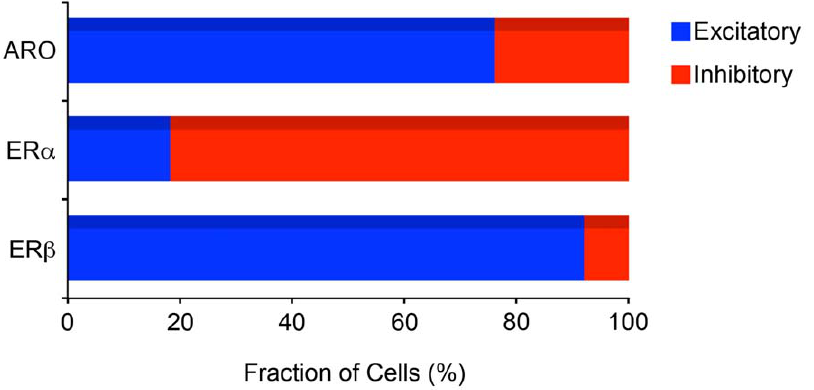
Figure 5. Estrogen-associated circuits in V1 are neurochemically distinct. Horizontal bar graphs expressing the percentage ( 6 S.E.) of estrogen-producing (ARO-positive) and estrogen-sensitive (ER a and ER b -positive) neurons that are excitatory, as revealed by co-expression of vGlut2 mRNA, or inhibitory, as revealed by co-expression of GAD65 mRNA. Note that whereas most ARO- and ER b -positive cells are excitatory, the vast majority of neurons expressing ER a are GABAergic